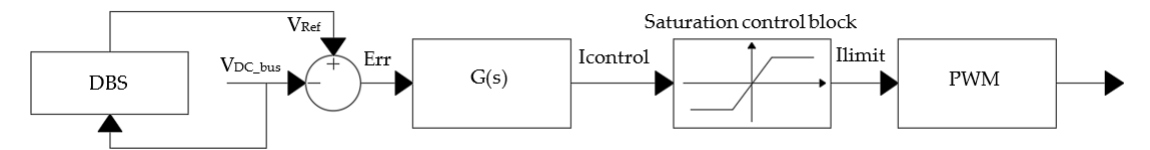
Figure 3. Control scheme of Smart User Network (SUN) LC.